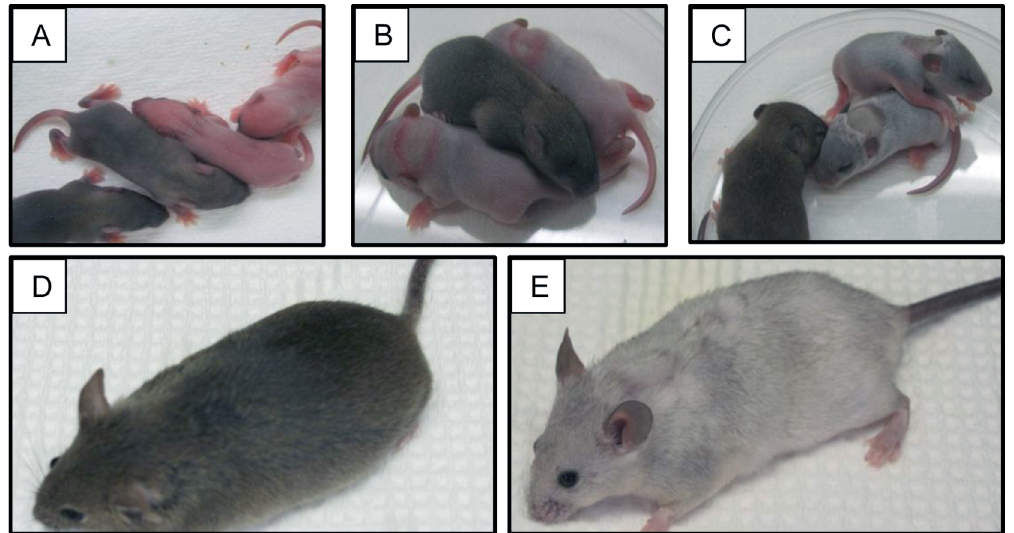
Figure 1. Phenotypic response of Mo Br / y mice to copper injection. Mice were photographed before and after copper treatment to exemplify the dramatic phenotypical changes that occur in the mutants. ( A ) 7-day-old male mice prior to treatment. Mutant males are pink. ( B ) 8-day-old mice after first Cu injection. ( C ) 9-day-old mice after second Cu injection. ( D ) 3-month-old WT male. ( E ) 3-month-old copper-treated Mo Br / y male. In panels A, B & C, untreated WT littermates are shown for comparison.